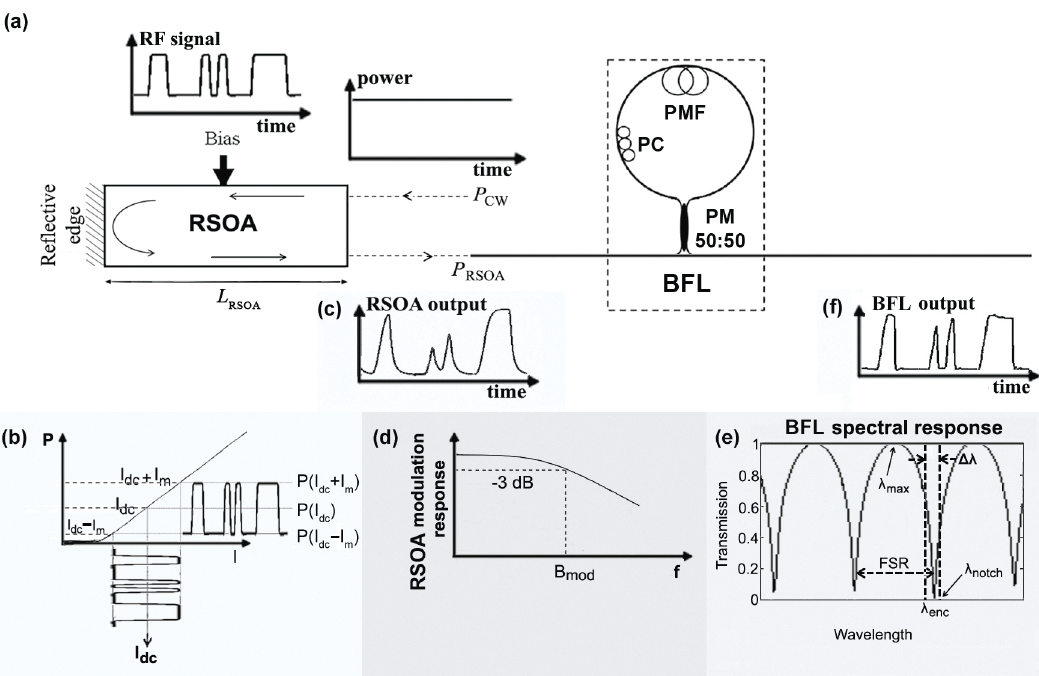
Figure 1. Illustration of RSOA directly modulated by NRZ data followed by serially connected BFL. ( a ) Block diagram. ( b ) P-I curve. ( c ) Stand-alone RSOA temporal output profile. ( d ) RSOA electrical modulation response. ( e ) BFL spectral response. ( f ) BFL-assisted RSOA temporal output